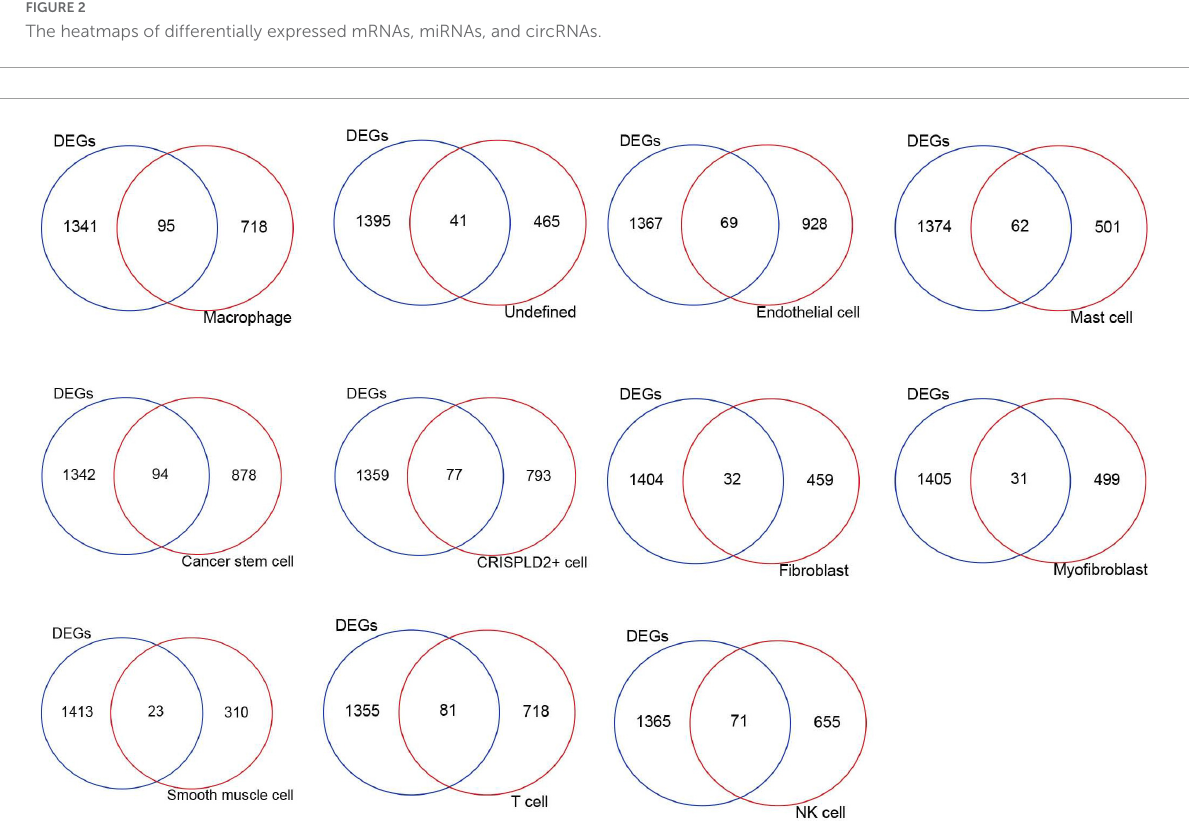
FIGURE3 The intersection Venn diagram of differentially expressed mRNAs and highly expressed genes in each cell type.